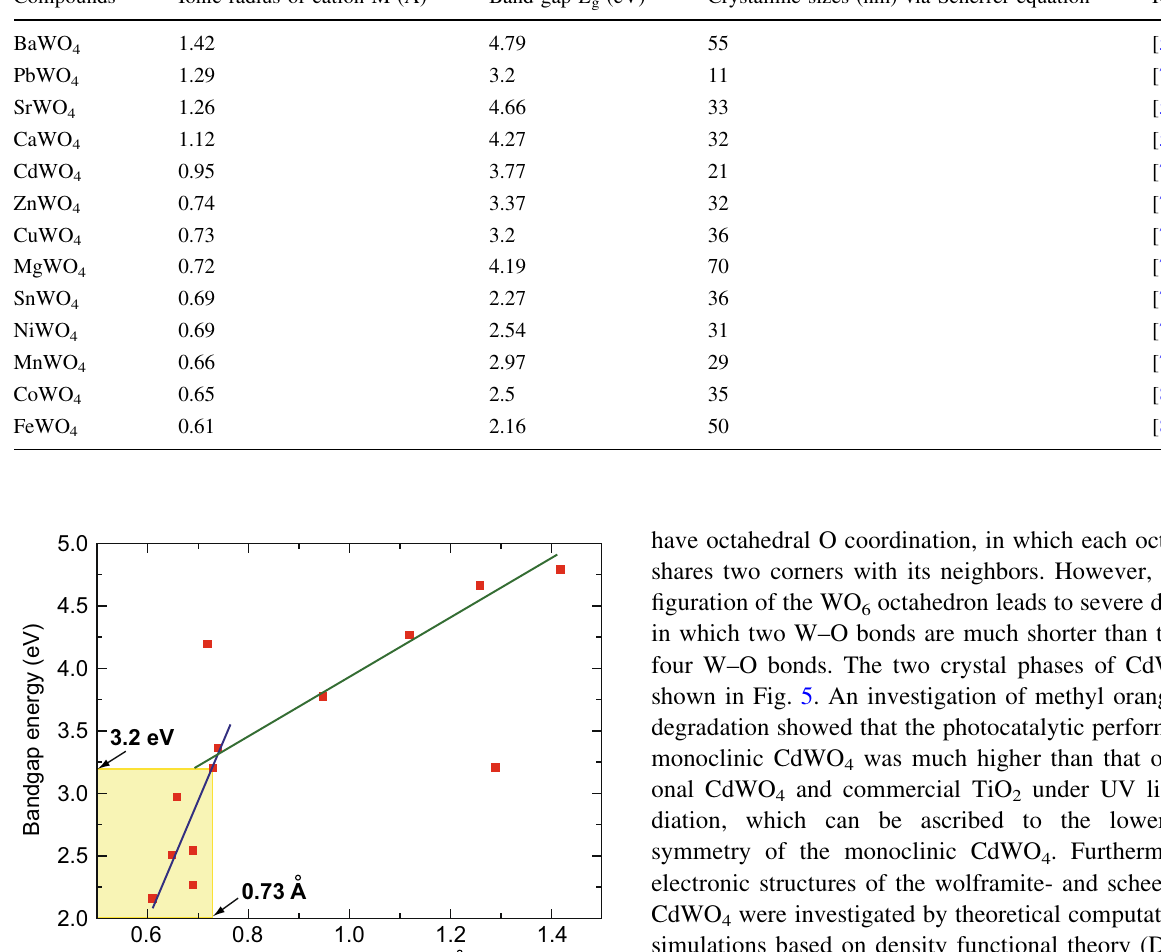
Table 1 Band gaps, crystal sizes, and effective ionic radii of different MWO 4 materials Compounds Ionic radius of cation M (A˚ )